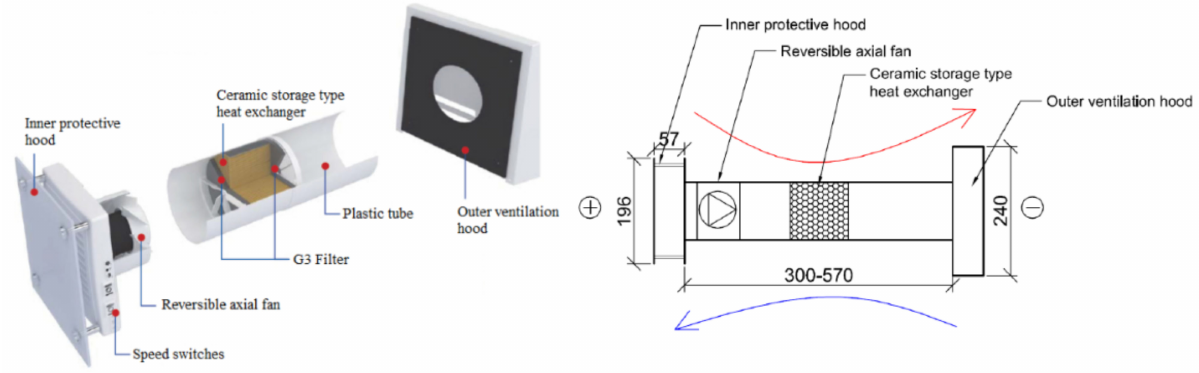
Figure 12. Decentralized ventilation unit with reversible fan and ceramic heat exchanger